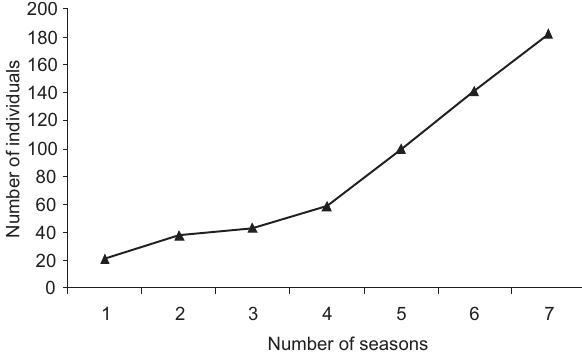
Figure 6. Rate of discovery curve for S. guianensis photo-identified in distinct seasons in the Paranaguá Estuarine Complex, Brazil be- tween April 2006 and July 2008.